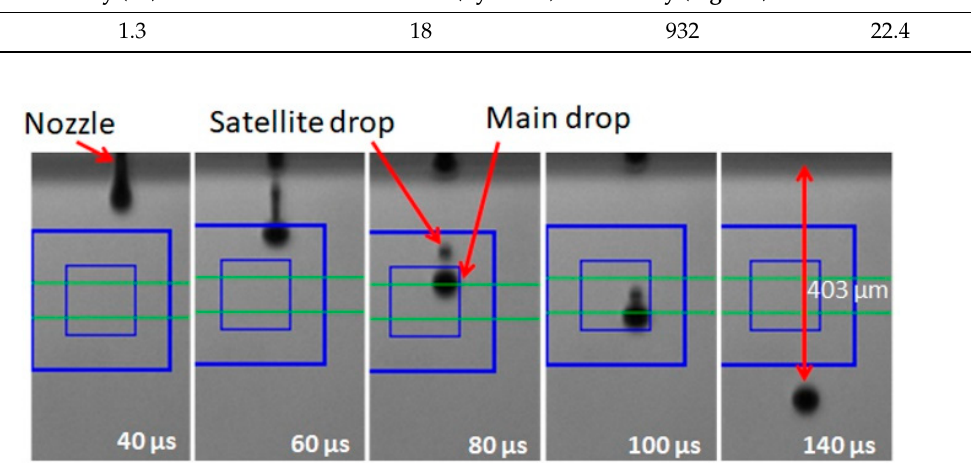
Figure 1. Pictures of drop formation of Cs 2 CO 3 ink. The volume and the velocity of drop at 140 µs are, respectively, 21 pL and 2.88 m/s.